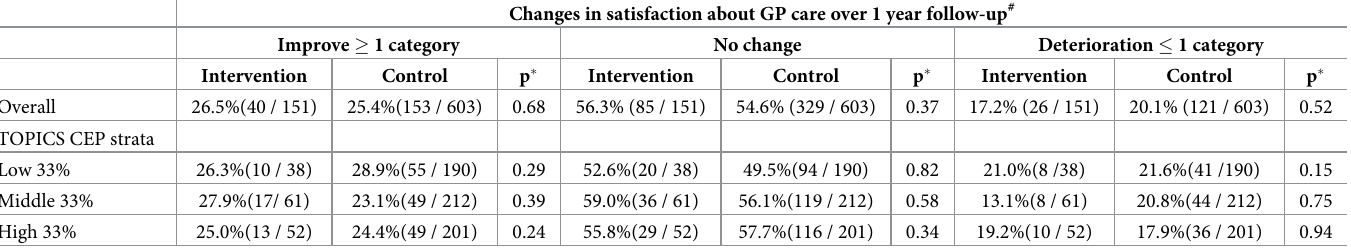
Table 3. Changes in satisfaction about GP care over 1-year follow-up during implementation of integrated care in the intervention group compared to usual care (control), depending on perceived health